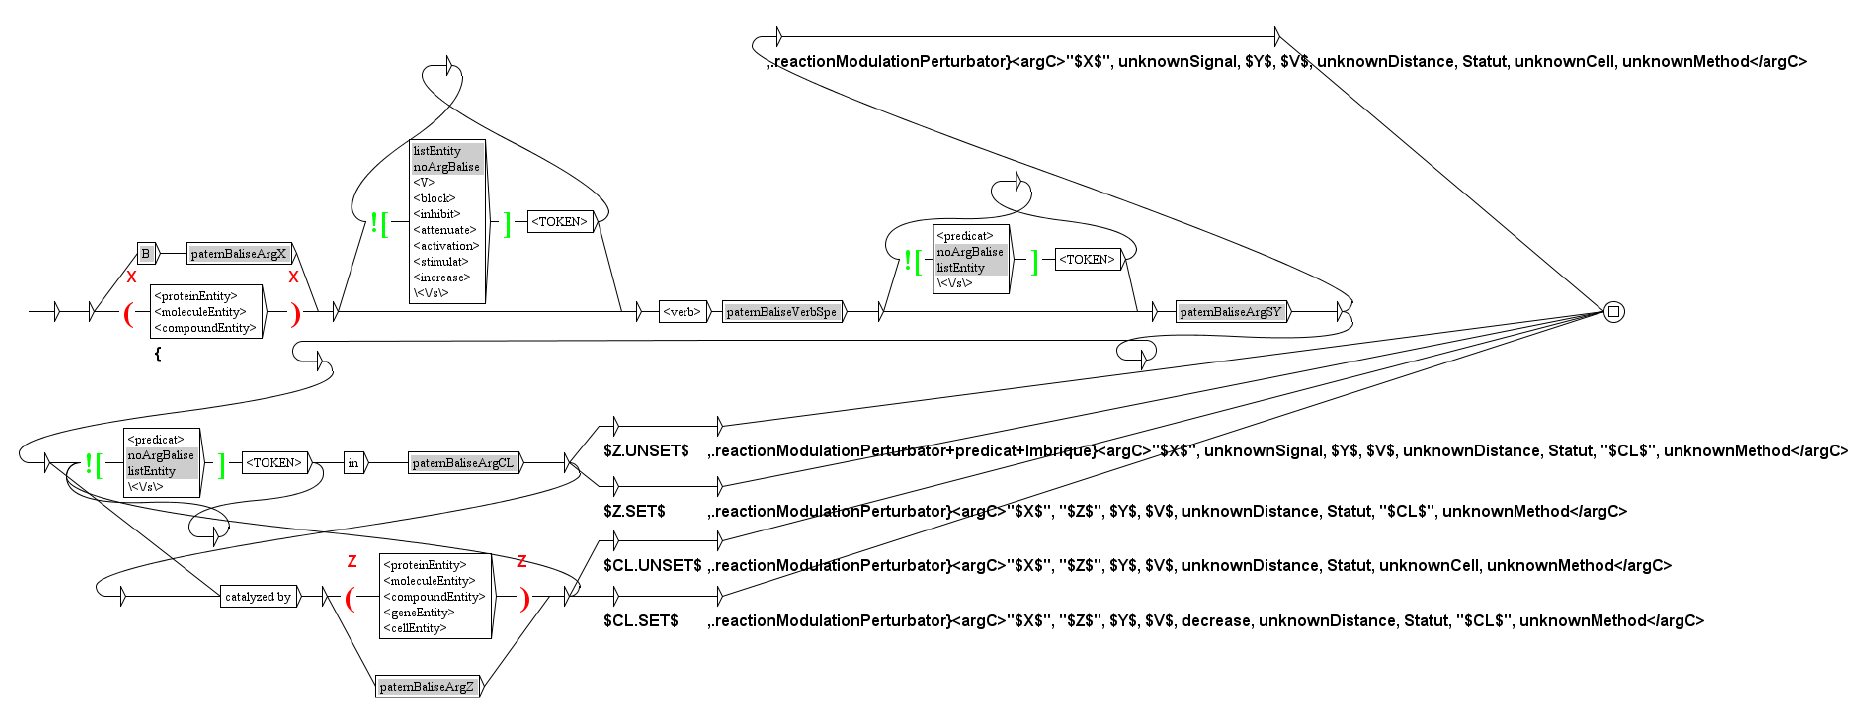
Figure 11. The graph to tag predicates of type reactionModulationPerturbator